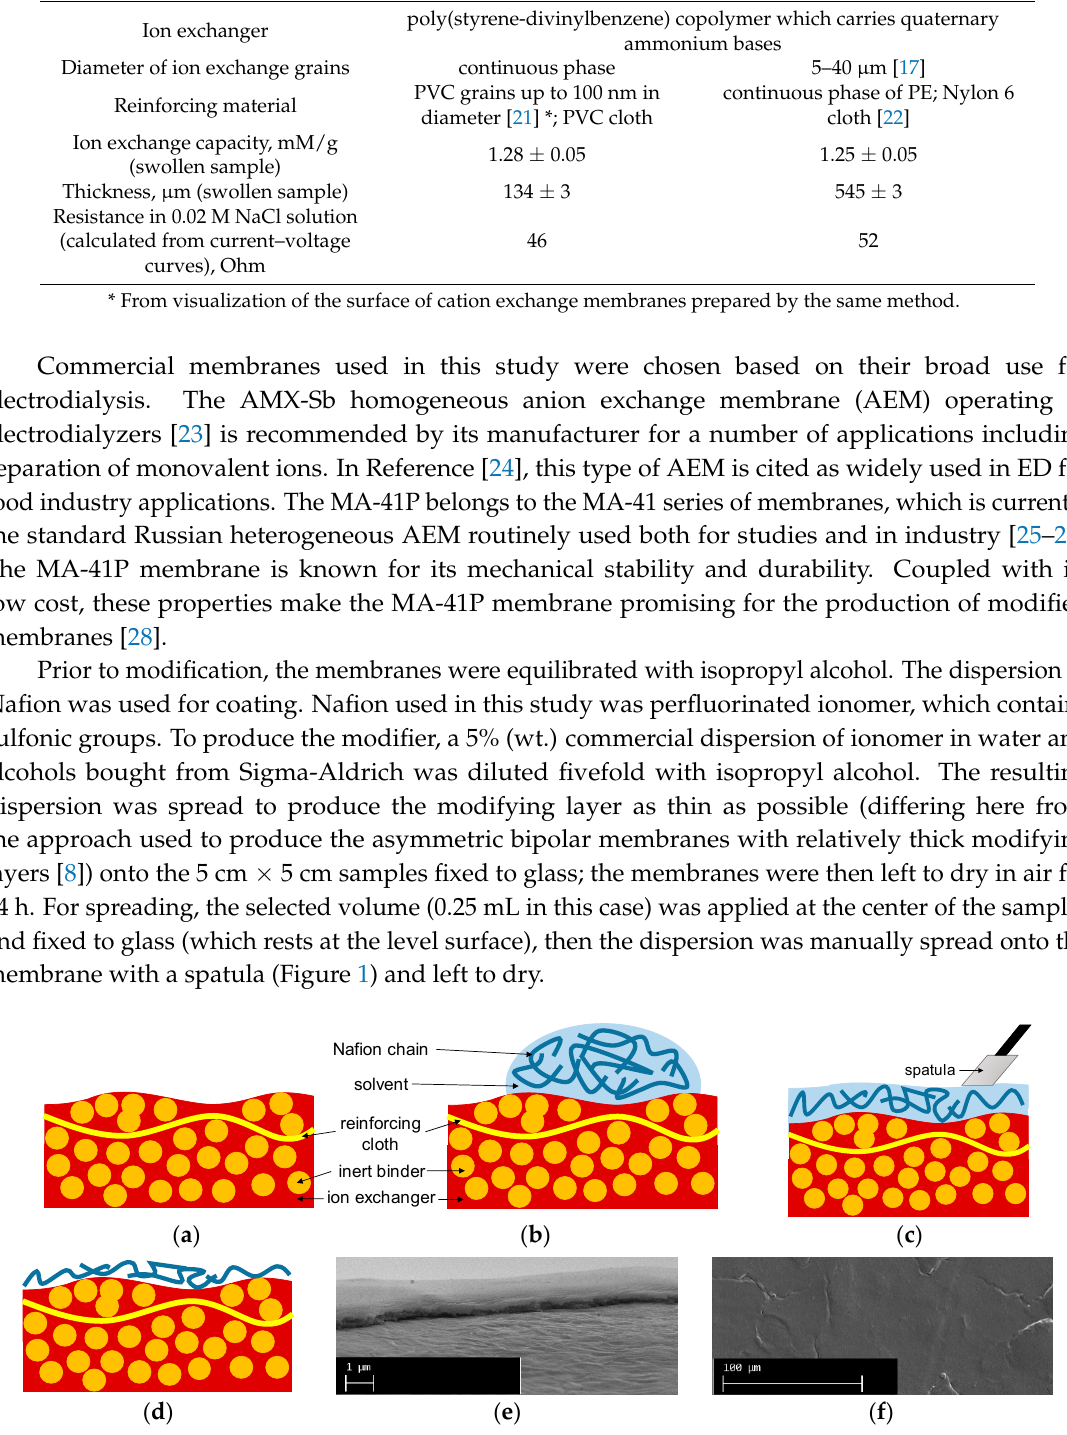
Figure 1. Sketch of the process of modification ( a – d ) and fragments of SEM images of resulting membranes. ( a ) The commercial membrane to be subjected to modification (the sketch illustrates the case of AMX-Sb); ( b ) the modifying dispersion is applied; ( c ) it is manually spread with a spatula; ( d ) the solvent evaporates, leaving the relatively thin modifying layer. ( e ) A fragment of an SEM image portraying a cross section of MA-41P membrane modified with one layer of polyelectrolyte; ( f ) A fragment of an SEM image showing a top view of the same membrane. fragment of an SEM image showing a top view of the same